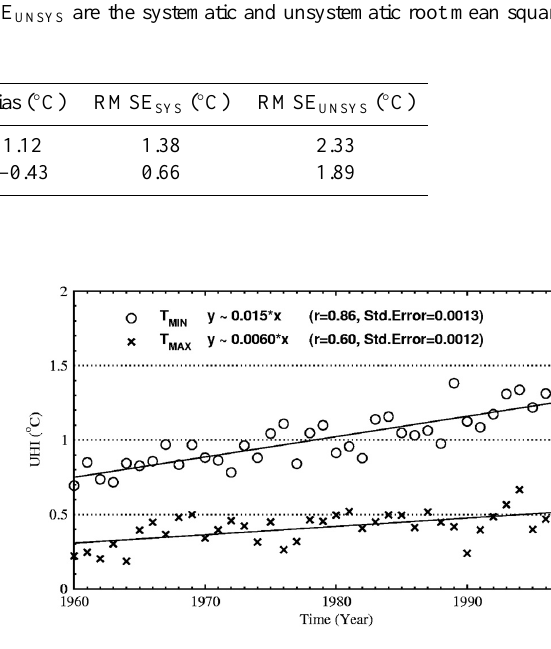
Figure 5. The summer-mean urban heat island (UHI) e ff ect on minimum and maximum near-surface air temperature estimated as the di ff erence between the “rural” and “urban” model integrations with the linear trend, 1960–1999. r is the correlation coe ffi cient and Std.Error is the standard error of the regression coe ffi